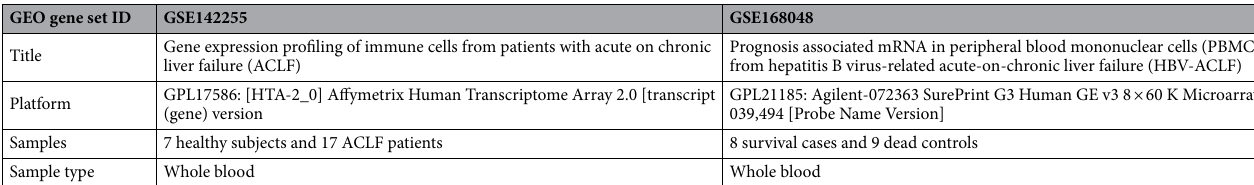
Table 1. Summary of the three ACLF datasets from the GEO